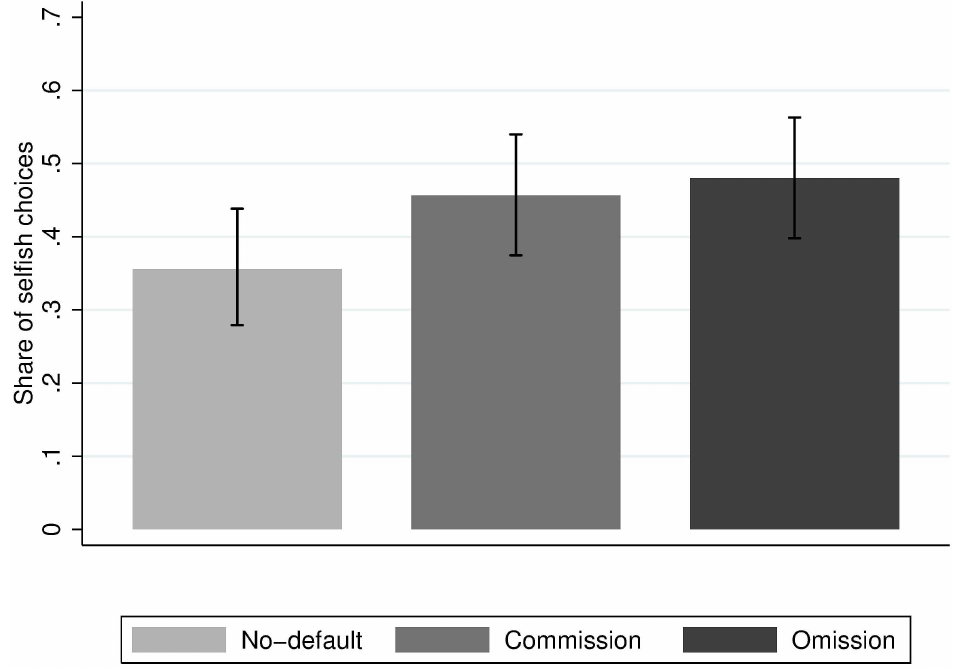
Fig 3. Average share of selfish choices across treatmentsin Experiment